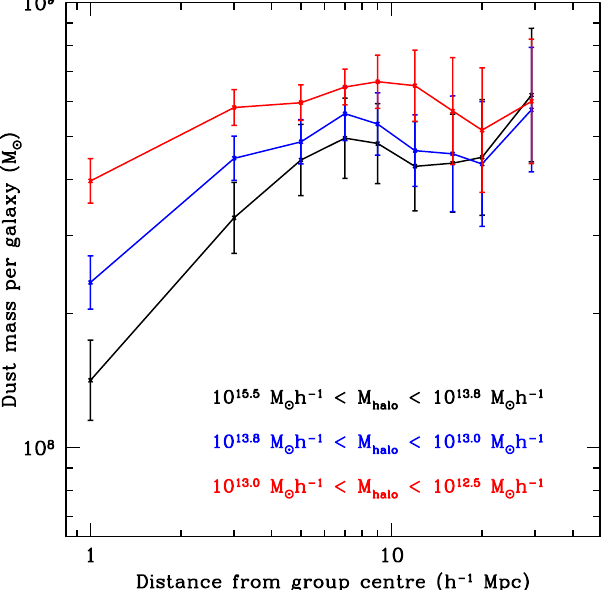
Figure 1. The excess of dust mass per excess galaxy due to gravitational lensing versus the distance from the cluster (group) center. Three curves correspond to different mass bins of clusters from small to higher masses as follows from the uppermost to the lowermost; see Figure 9 in [30]. Reproduced with permission from S. L. McGee & M. L. Balogh, published by RAS (MNRAS),